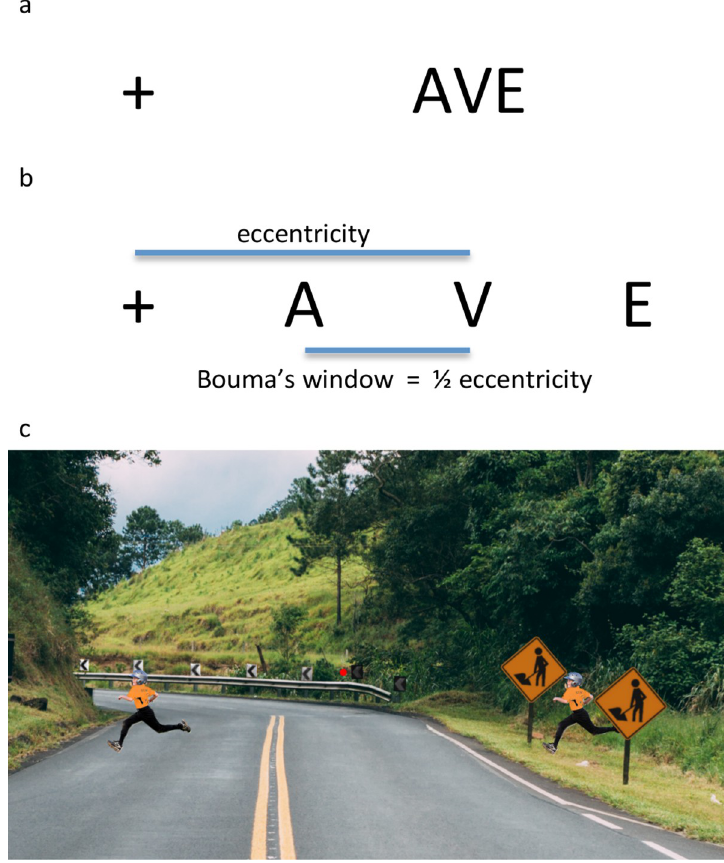
Fig 1. Crowding. a. In crowding, the perception of a target element deteriorates in the presence of nearby elements. When fixating the left cross, the target letter V on the right is hard to identify because of the nearby flankers. b. The task is easier than in (a), because the flankers are further away from the target letter V. Bouma’s law states that crowding occurs only when flankers are sufficiently close to the target, within the so-called Bouma’s window. c. Crowding is a ubiquitous phenomenon since elements are rarely seen in isolation. For example, when fixating the central red dot, the child on the left is easier to detect because it is not surrounded by nearby flankers, as is the child on the